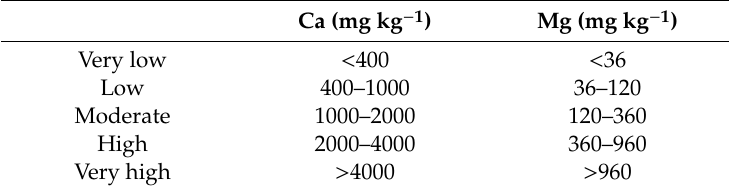
Table 5. Ca (mg kg − 1 ) and Mg (mg kg − 1 ) concentrations in the soil for crop production